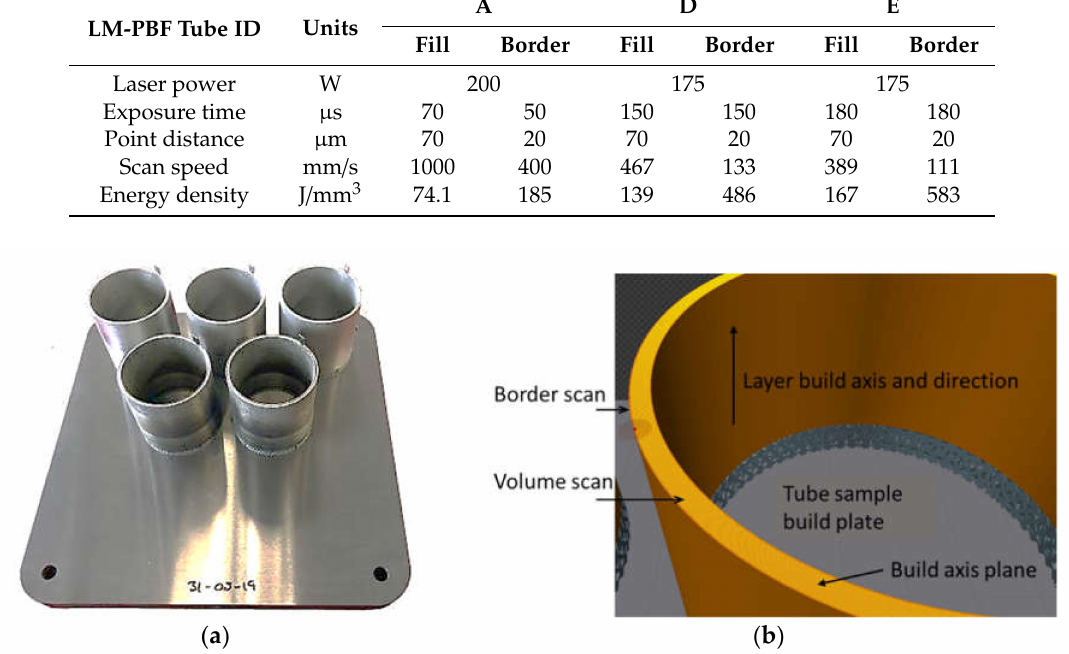
Figure 2. Additive manufacturing (AM) fabricated tube samples in the Renishaw AM250 SLM machine ( a ), and tube sample build orientation definitions ( b ). Table 2. Porosity measurements of LM-PBF tube samples A, D, and E.